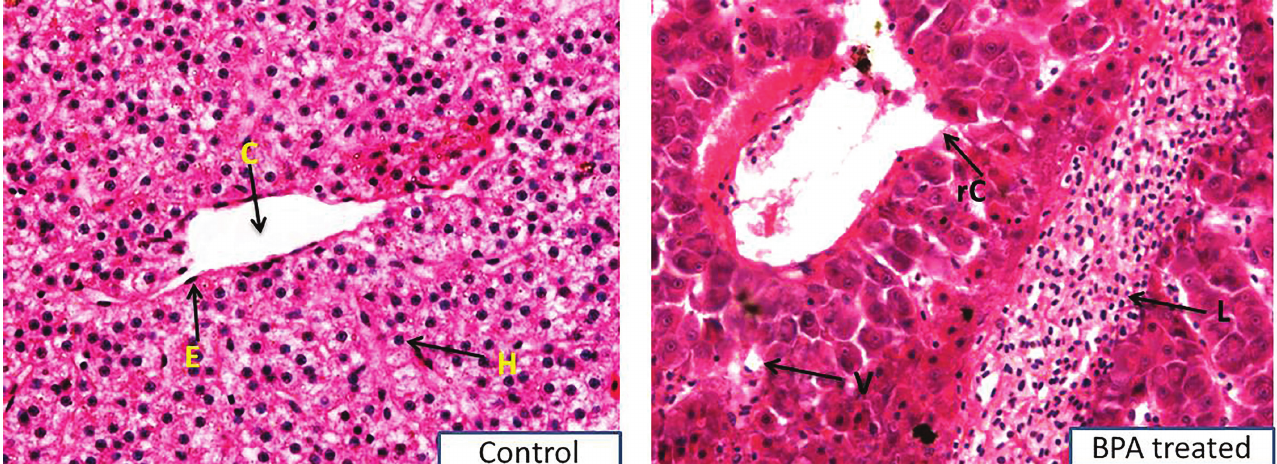
FIGURE 1 - Liver tissue of C. idella from control and treated group exposed to the sublethal concentration of BPA for 14 days. (C) central vein; (E) epithelial layer; (H) hepatocyte; (V) lipid type vacuolization; (rC) ruptured central vein; (L) lymphocyte infiltration. H&E stain, 40X.